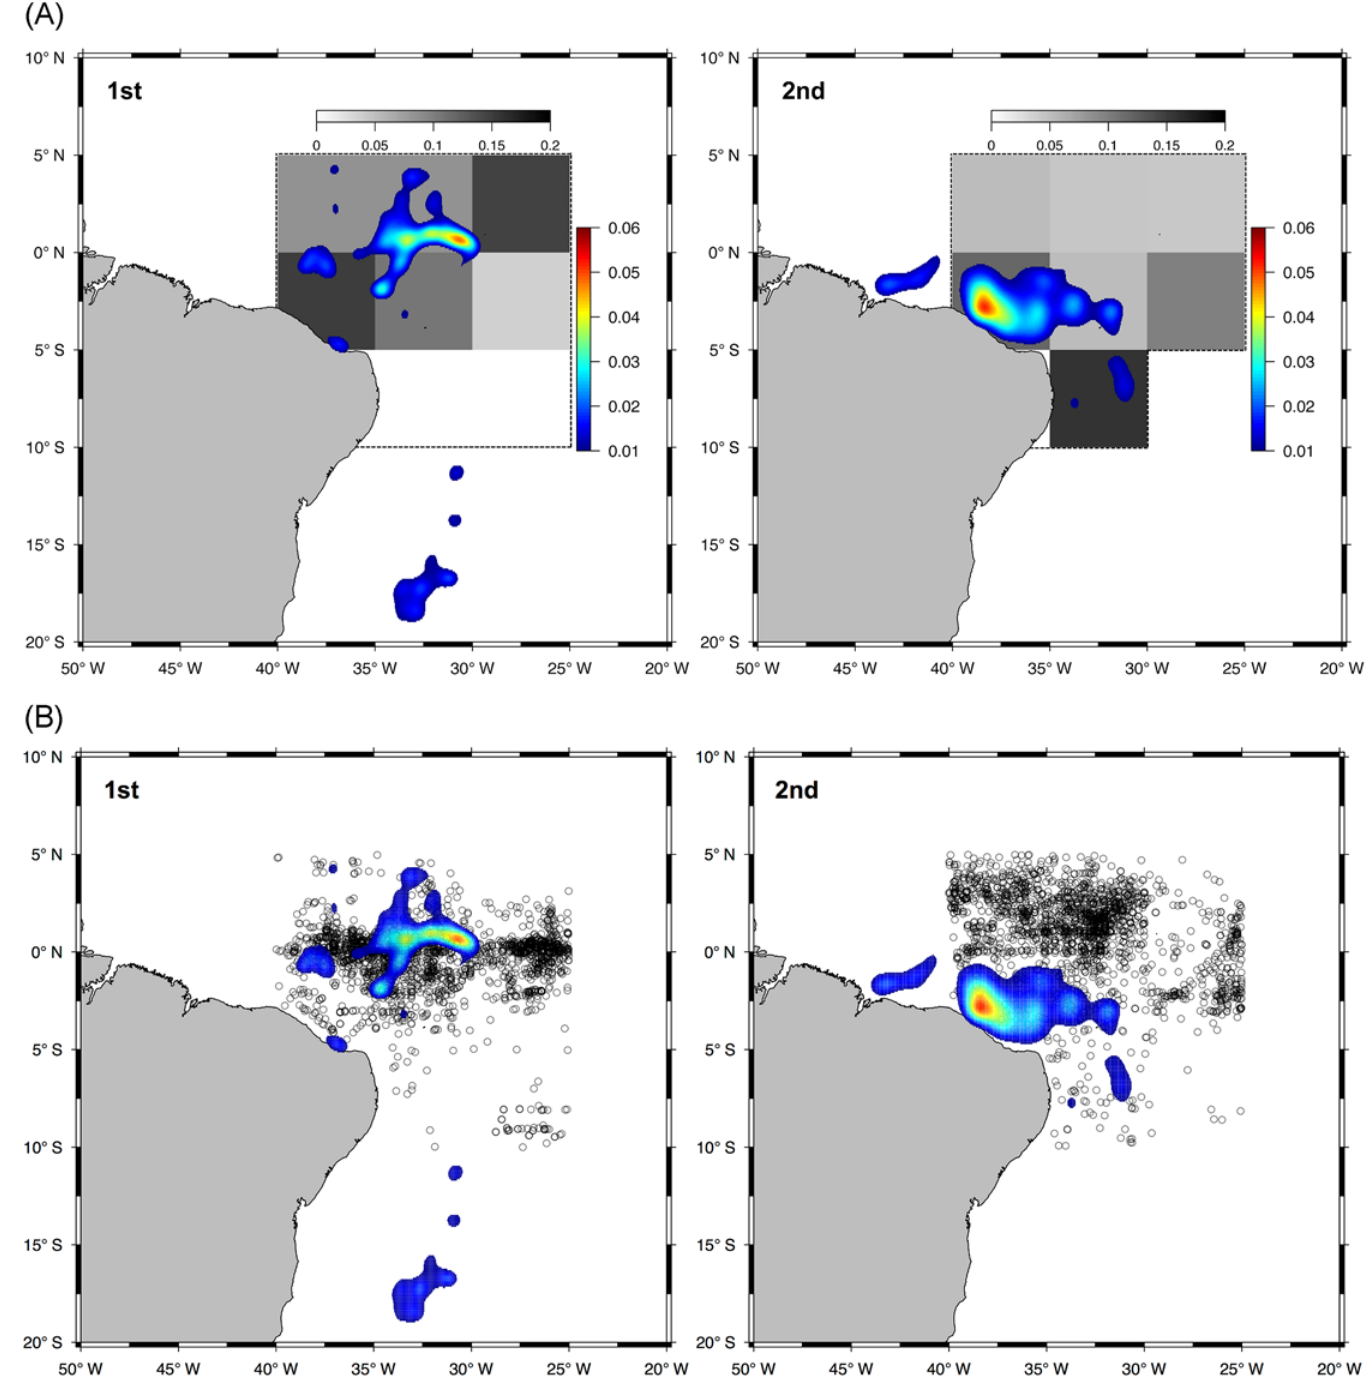
Fig 8. Kernel density estimation of post-processed tracks showing the areas of high utilization by oceanic whitetip sharks tagged in the western Atlantic Ocean between 2010 and 2012. The left panel represents the 1 st quarter of the year and the right represents the 2 nd . (A) Values of occurrence per set (grey scale) for the species from foreign tuna longline vessels chartered by Brazil operating from 2004 to 2010. Doted lines mark the area where the occurrence data were analyzed. (B) Fishing sets locations (circles) from foreign tuna longline vessels chartered by Brazil operating from 2004 to